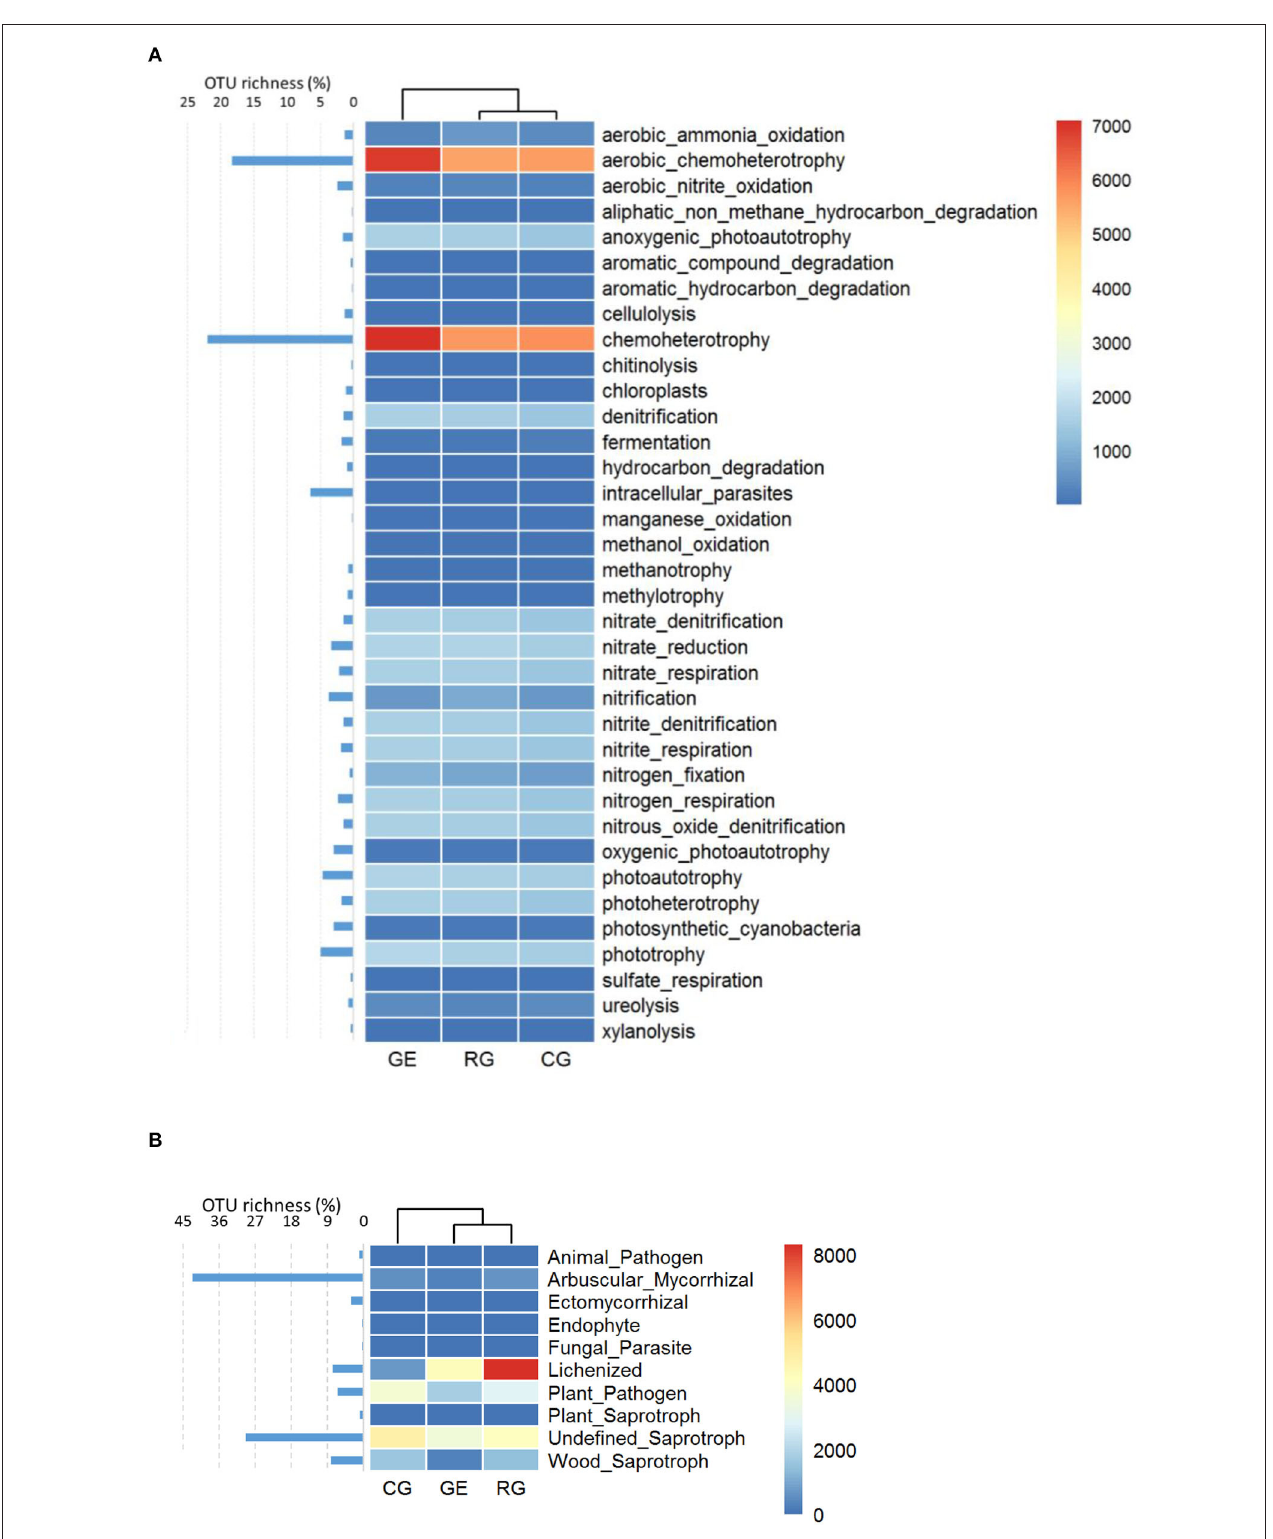
FIGURE 4 | The relative abundance and OTU richness of bacterial (A) and fungal functional guilds (B) . GE, grazing exclusion; RG, rotational grazing; and CG, continuous grazing.